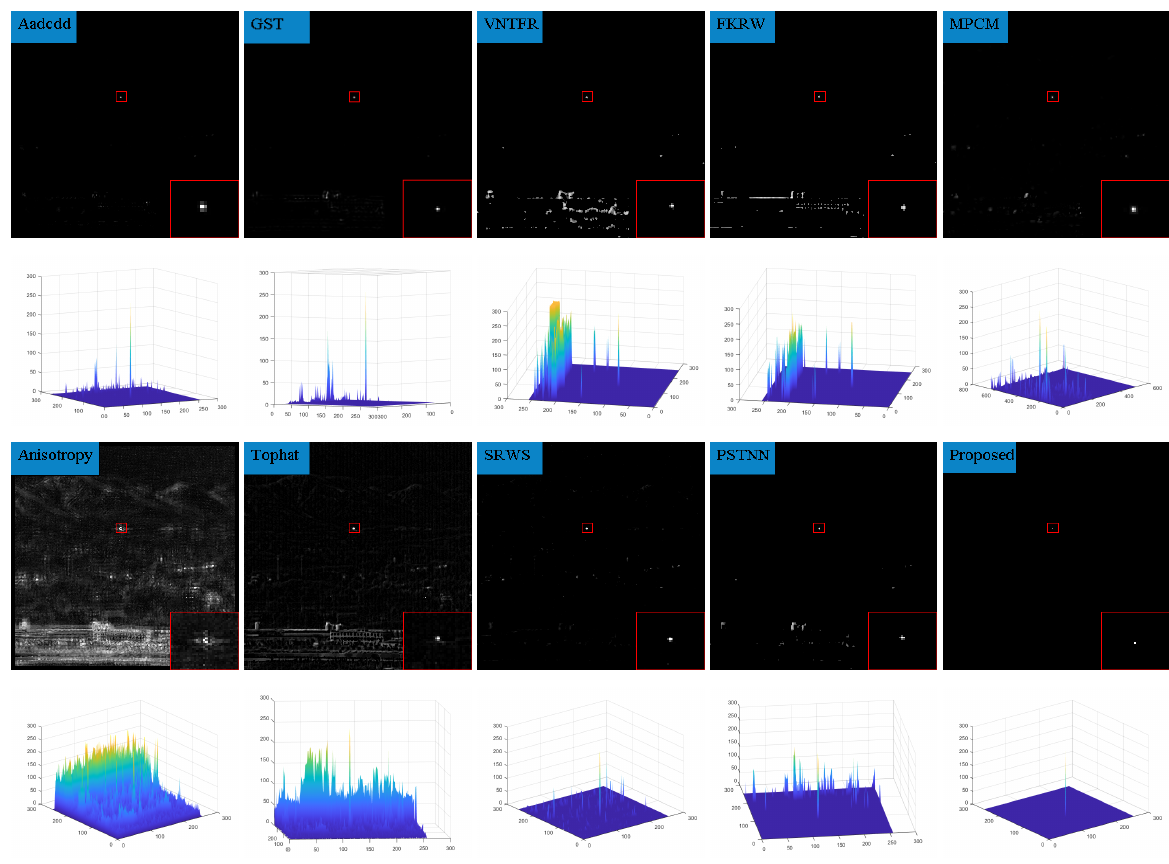
Figure 12. Detection results of sequence 4.